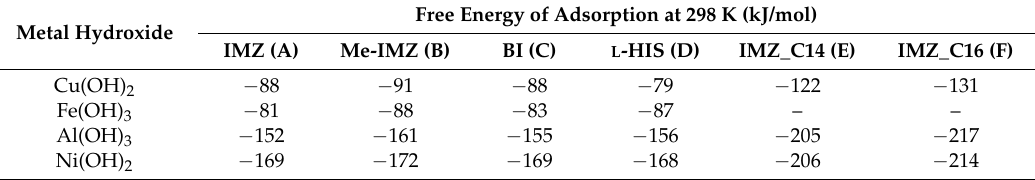
Table 4. Free Energy of adsorption (kJ/mol) of different corrosion inhibitors on to various metal hydroxide substrates at 298 K in presence of water. Binding Energies from Table 2 and log P values with reference to n -octanol from Table 3 are